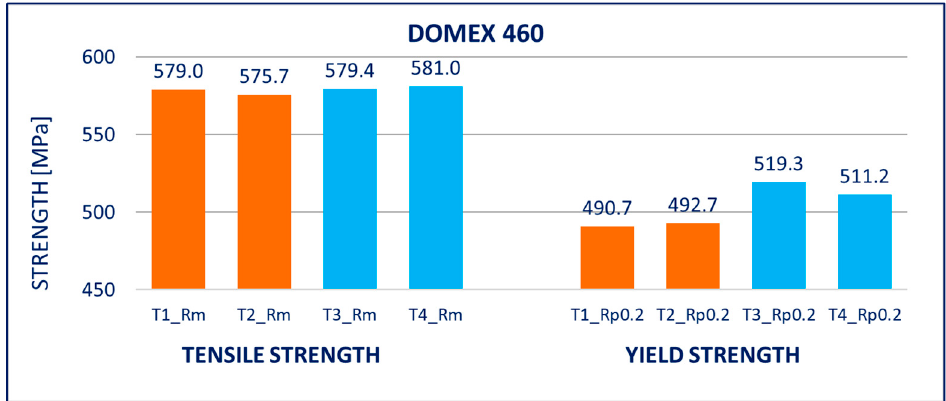
Figure 5. Tensile tests of specimens from DOMEX 460 steel. Description of specimens: T1 and T2 are groups of specimens without zinc coating; T3 and T4 are groups of specimens after hot-dip galvanization. R m is tensile strength, R p0.2 is yield strength.